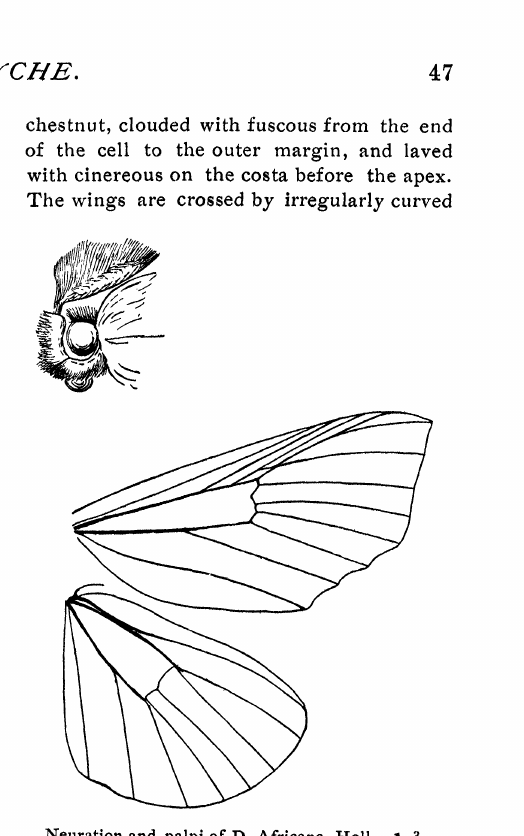
. Neuration and palpi of D. Africana, Holl., o*, and somewhat indistinct transverse basal, sub-basal, median, limbal, and submarginal brown lines. There is a dark annular spot in the middle of the cell, and a larger similarly colored reniform spot at the end of the cell. The fringes are dark brown marked narrowly with white on the interspaces. The second- aries are dark fuscous, except on the costa near the base, where they are white, shining. ’. Palpi, The fringes are paler than on the primaries, thorax, and upper side of abdomen pale chest- and are marked with fuscous at the tips of the nut. nervules. On the under side, the primaries are broadly dark fuscous on the middle area with the inner margin white, shining; the costa and the outer margin are bordered with pinkish-rufous. There is a small subtrian- gular fuscous spot on the costa just before